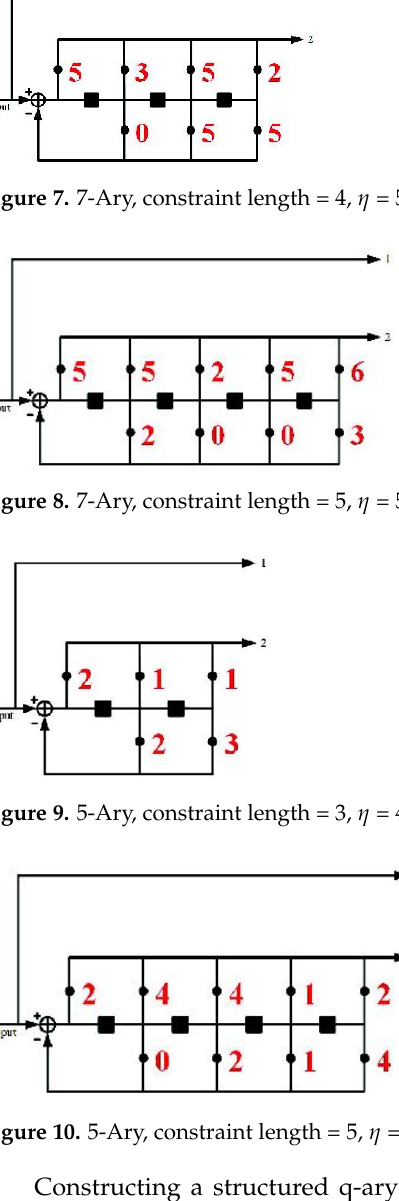
Figure 6. 5-Ary, constraint length = 4, η = 5.1. Figure 6. 5-ary, constraint length = 4, Figure 6. 5-ary, constraint length = 4,